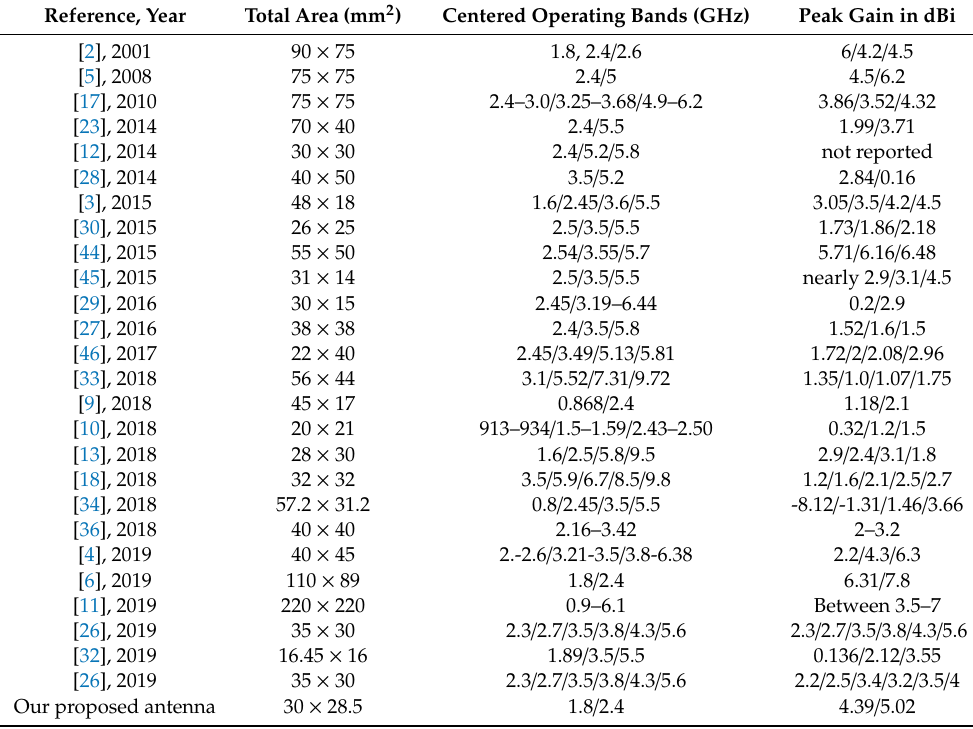
Table 1. Antenna dimensions and properties comparison with published